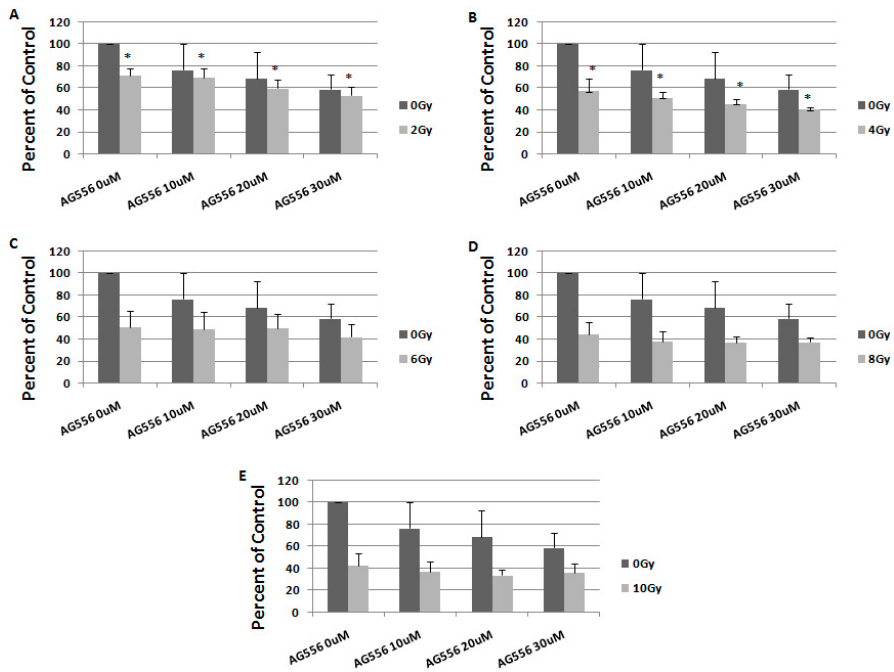
Figure 8. The effect of EGFR inhibition on ionizing radiation response in 15 HGG cells, seven days after the treatment. The cells were seeded in 96-well culture plates (3000 cells/well) then irradiated with 2 Gy ( A ); 4 Gy ( B ); 6 Gy ( C ); 8 Gy ( D ); 10 Gy ( E ) and treated with 10 μ M, 20 μ M or 30 μ M AG556. The cells were incubated for seven days and cell viability was determined by MTT assay. All results show the mean of two independent experiments ± SD, * p < 0.05 vs. irradiated cells.